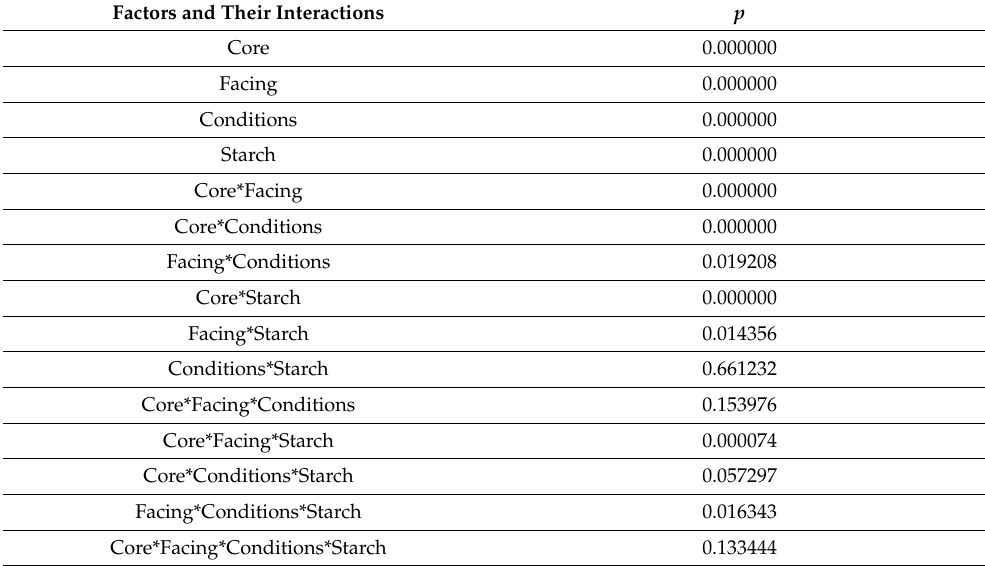
Table 10. Statistical significance for the model in the multidirectional classification taking into account the direction of the Y